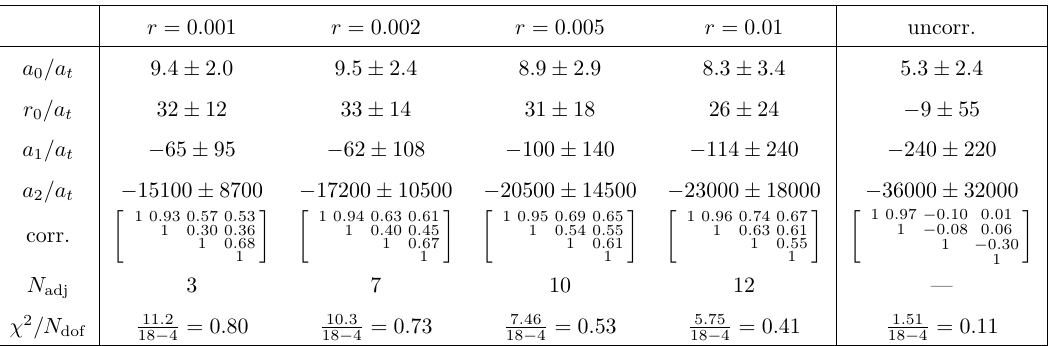
Table 11 . D ¯ K I = 0 scattering amplitude fits on the m π = 239 MeV ensemble, as in eq. (5.12) but with small eigenvalues adjusted as described in the text (four columns labelled by r ) or correlations between finite-volume energies set to zero (final column). N adj is the number of small eigenvalues adjusted. While adjusting the eigenvalues of the covariance matrix could be considered to have reduced the number of degrees of freedom, here the χ 2 /N dof are presented with the original N dof .